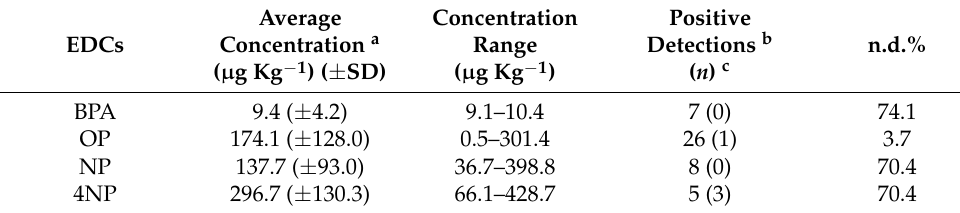
Table 2. Detected target EDCs residues in 27 samples of dairy